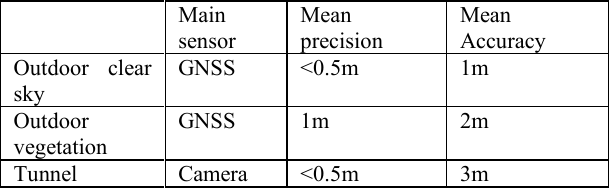
Table 1 . IOPES system horizontal performance at “Sa Falconera” test site.